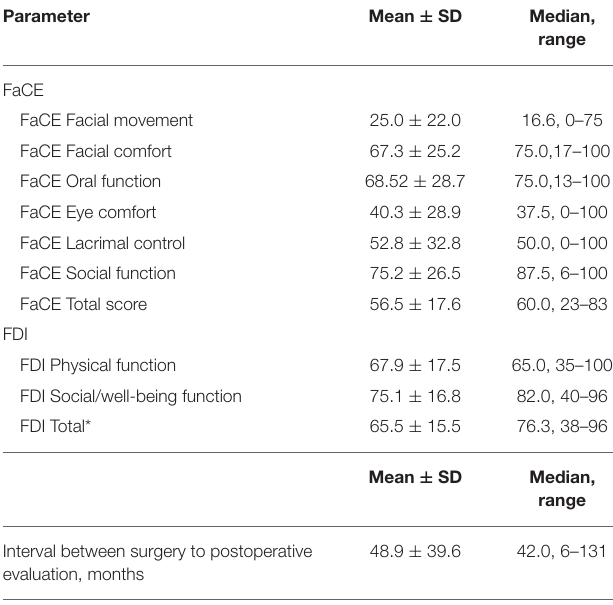
TABLE 2 | Quality of life after hypoglossal-facial jump nerve suture ( N =